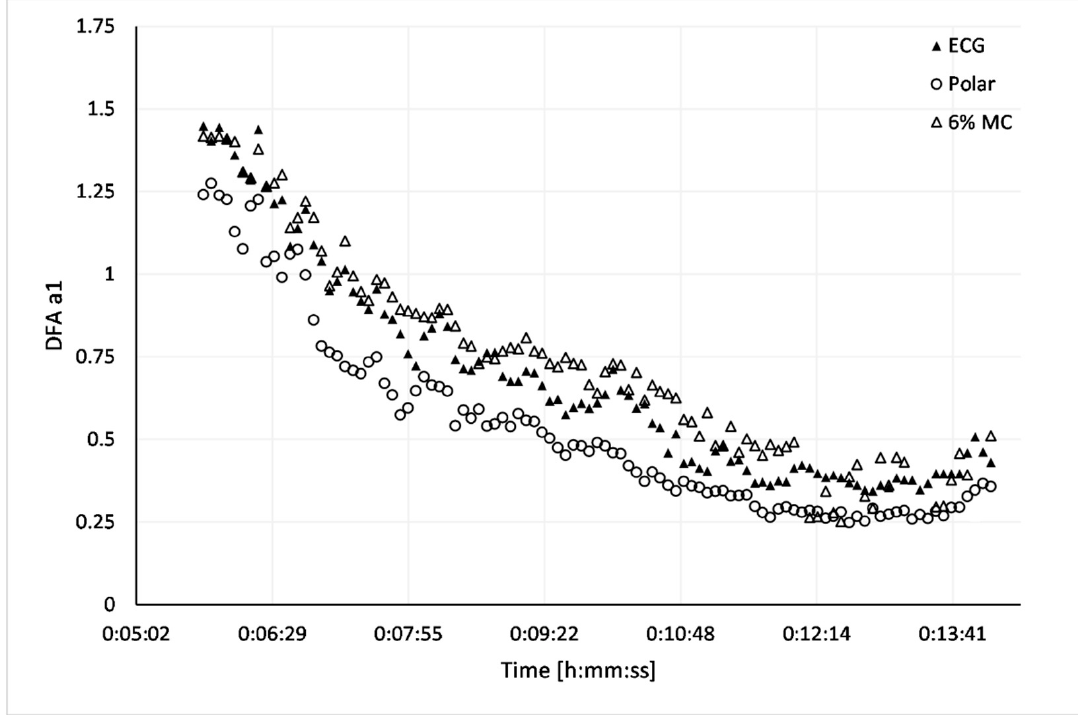
Figure 6. Time-varying analysis (window width: 120 s, grid interval: 5 s), DFA a1 for matched time series containing no artefact in one representative participant, ECG (solid triangle), Polar H7 (open circle), ECG 6% MC (open triangle).